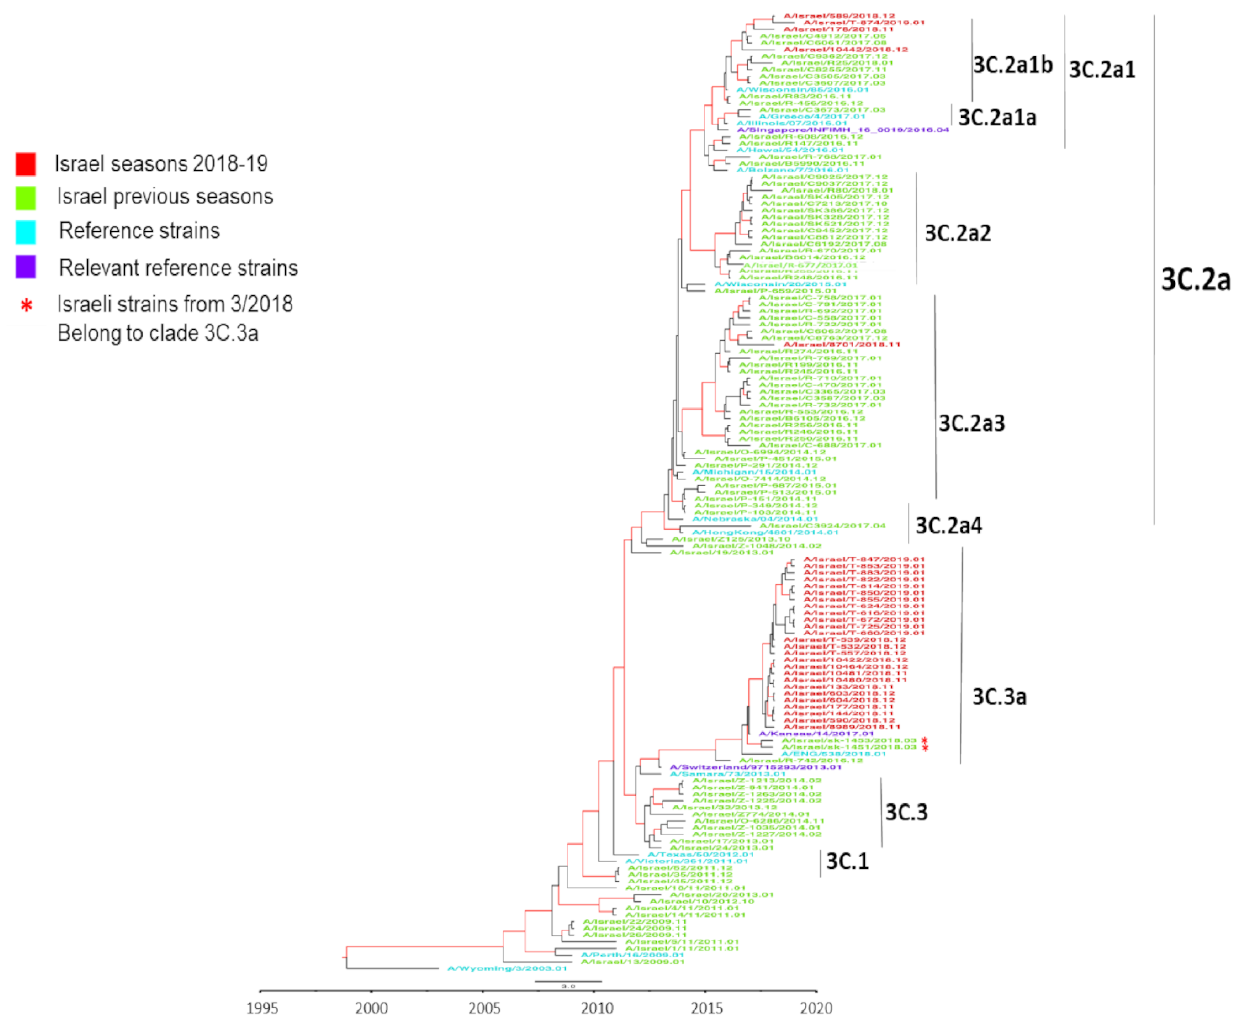
Figure 2. Influenza A(H3N2) hemagglutinin (HA) phylogenetic analysis using BEAST. A Bayesian maximum-clade- credibility time-scaled phylogenetic tree (BEAST) of seasonal influenza A(H3N2), generated by comparing 1701 nucleotides encoding the HA protein on a timeline of influenza samples from Israel, Europe, Asia, and USA over a 10 year period (2009 to 2019). Red indicates Israeli virus sequences from the 2018–19 season, light green indicates Israeli virus sequences from previous seasons (2009–2018), dark green indicates reference strains, light blue indicates relevant reference strains, dark blue indicates other country viruses from previous seasons (2009–2018), and purple indicates other country virus sequences from the 2018–19 season. Genetic distance is indicated by the scale bar above the year time bar. The numerals at the end of virus names (01–12) indicate the month of sample (virus)